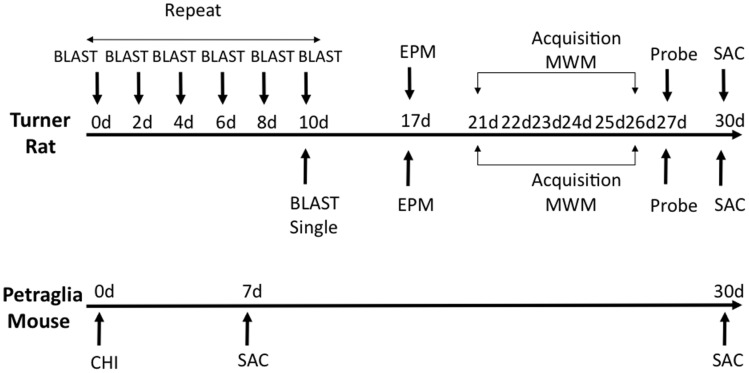
Schematic showing experimental design and behavioral experiments. Time of sacrifice for biochemical experiments is also shown.